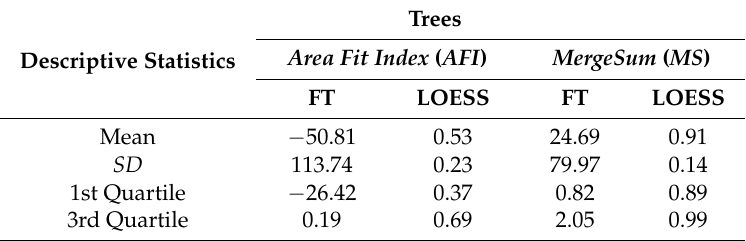
Table 4. Descriptive statistics for the Area Fit Index ( AFI ) and MergeSum ( MS ) metrics for the trees category based on 20 reference